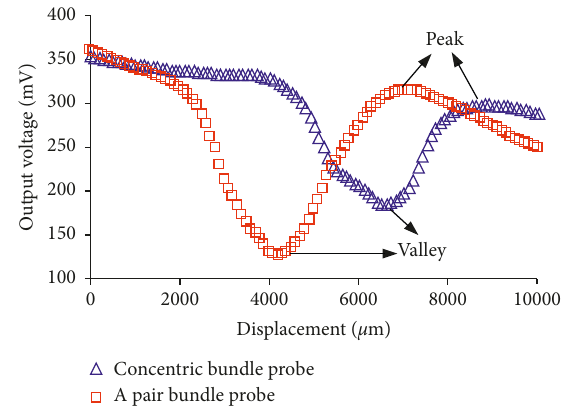
Figure 4: Graph of characterization of sensor probes displacement against concave